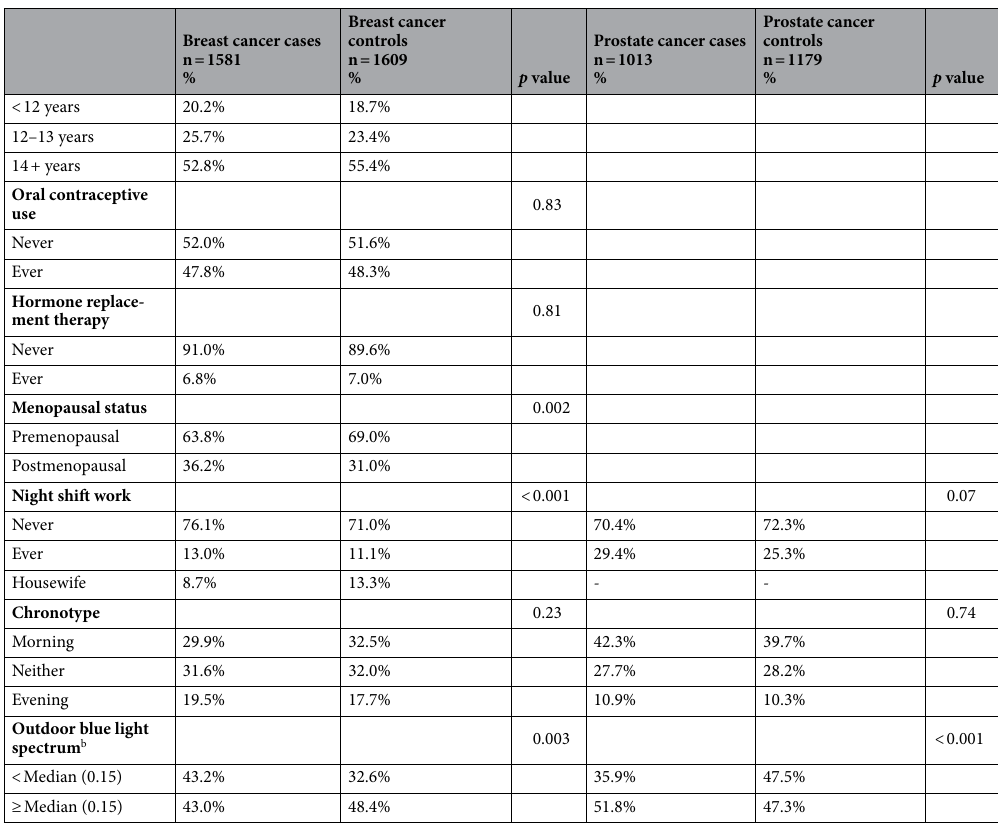
Table 1. Distribution of participant characteristics, breast and prostate cancer cases and controls, MCC-Spain, 2008–2013. Note in some cases the sum does not equal the total due to missing data. a Median = 1.63 ethanol g/ day in women and 18.8 ethanol grams/day in men. b Participants in Barcelona and Madrid only, n = 491 breast cancer cases and n = 467 breast cancer controls, n = 574 prostate cancer cases and n = 623 controls, current